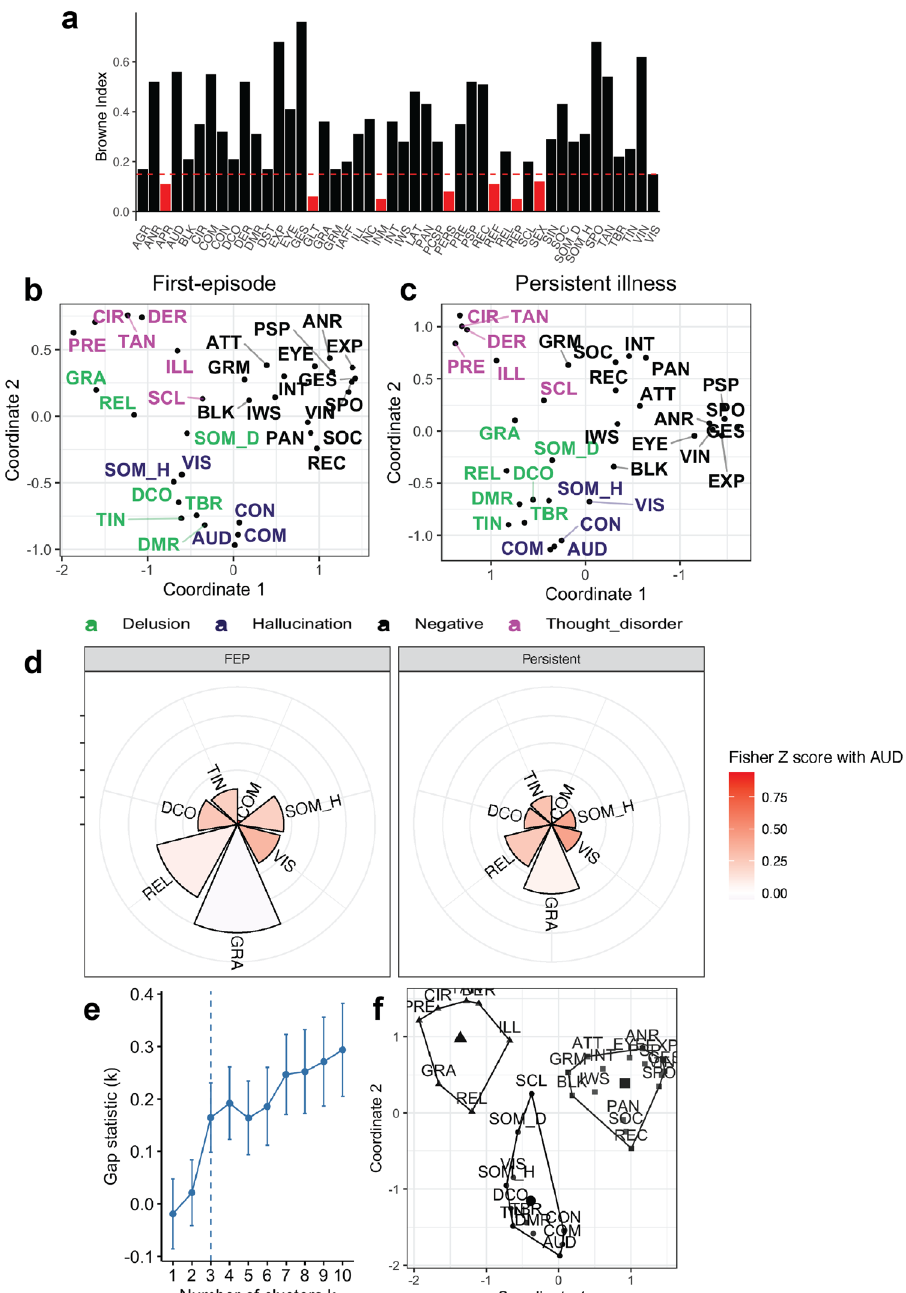
Figure 3. MDS solution for first-episode. ( a ) Browne index values for items from the FEP sample. Items in red are below threshold for inclusion. ( b ) MDS solution for FEP and ( c ) persistent illness sample with items which met inclusion at both sites. ( d ) Relative distances between various reality distortion items and auditory hallucinations (AUD) from MDS with their pairwise Fisher’s Z transformed correlation coefficients in color for FEP and persistent illness samples compared side-by-side. ( e ) Gap statistics across different number of clusters for k-means cluster analysis of FEP sample. Optimal number of clusters marked with vertical dashed line. ( f ) K-means cluster analysis solution with 3 clusters. CON: voices conversing, COM: